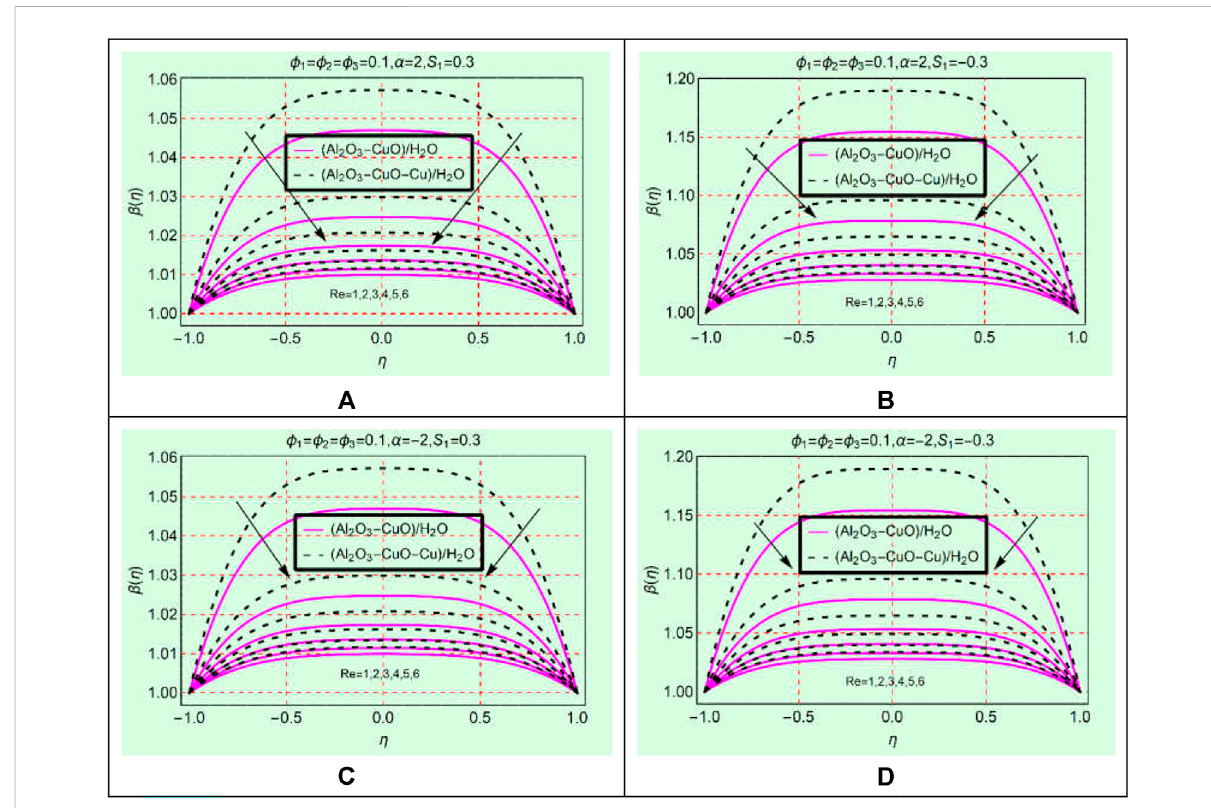
FIGURE 7 β ( η ) against Re (A) stretching and divergent, (B) shrinking and divergent, (C) stretching and convergent, and (D) shrinking and